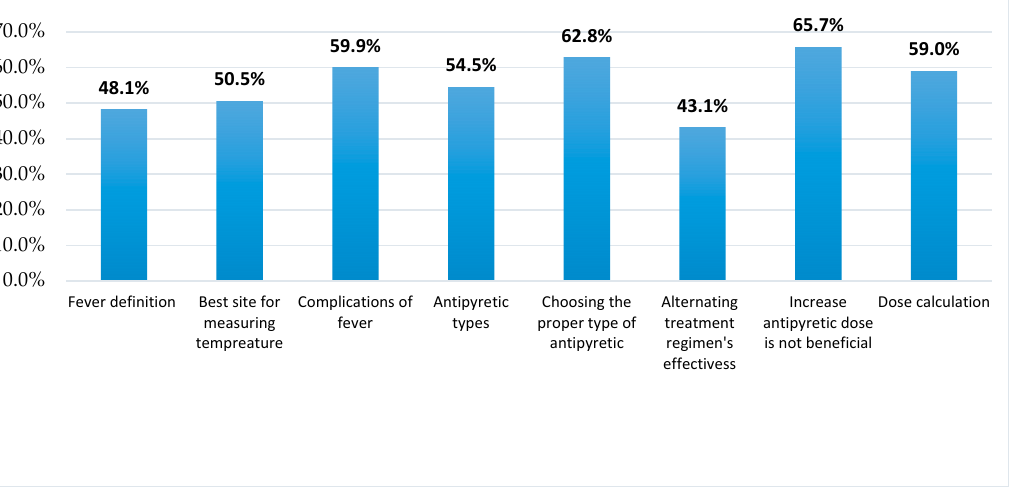
Figure 1. Percentages of correct knowledge scores of mothers about preschool childhood fever and its management.